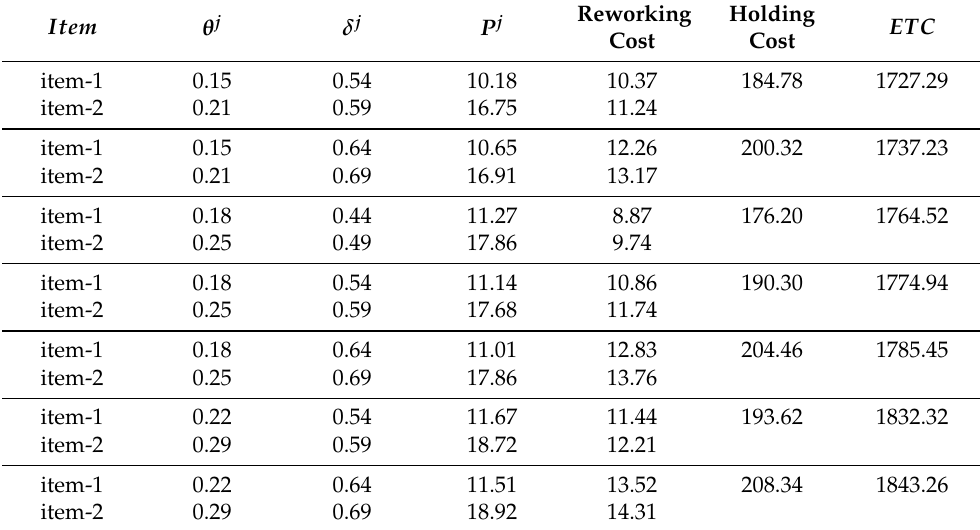
Table 5. Results for distinct values of defective rate ( θ j ) and rework rate ( δ j ) and their